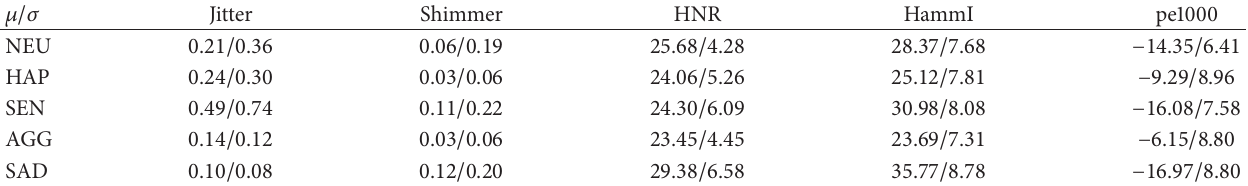
Table 4: Mean ( 𝜇 ) and standard deviation ( 𝜎 ) values for all VoQ parameters extracted from the expressive speech corpus.